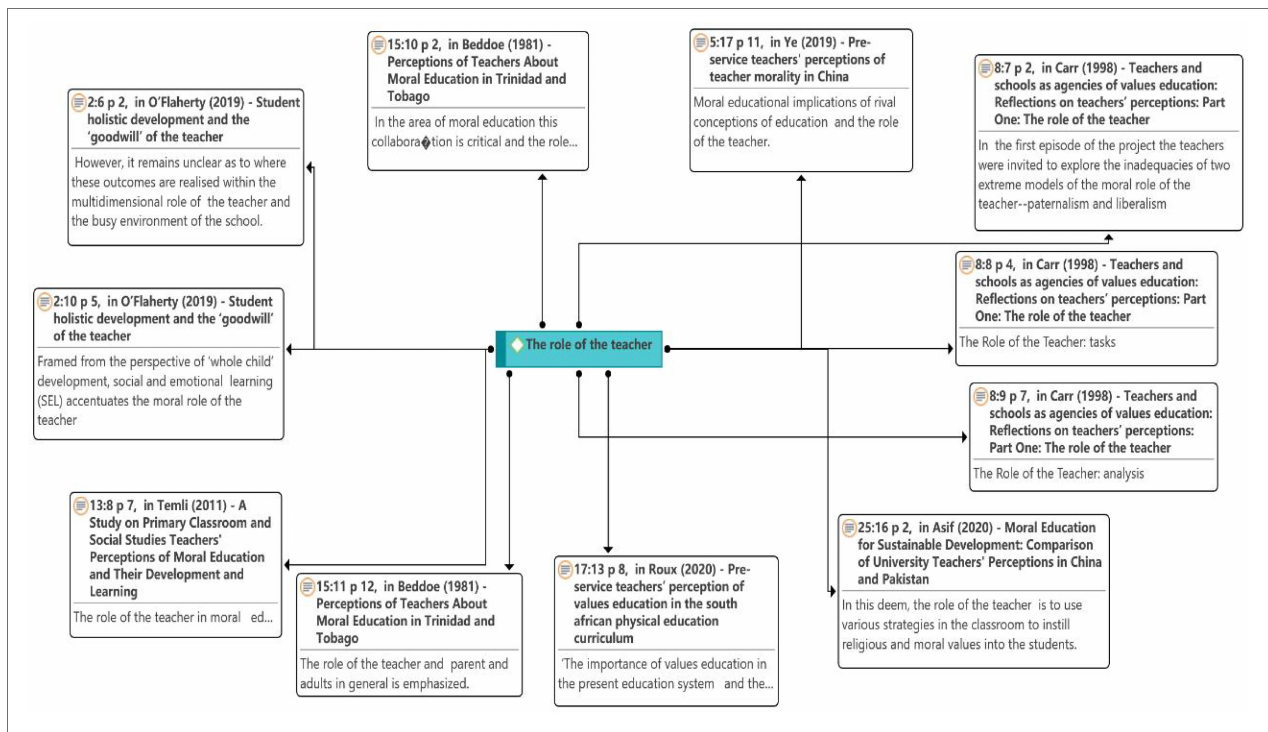
FIGURE 8 | Network on the role of the teacher theme.